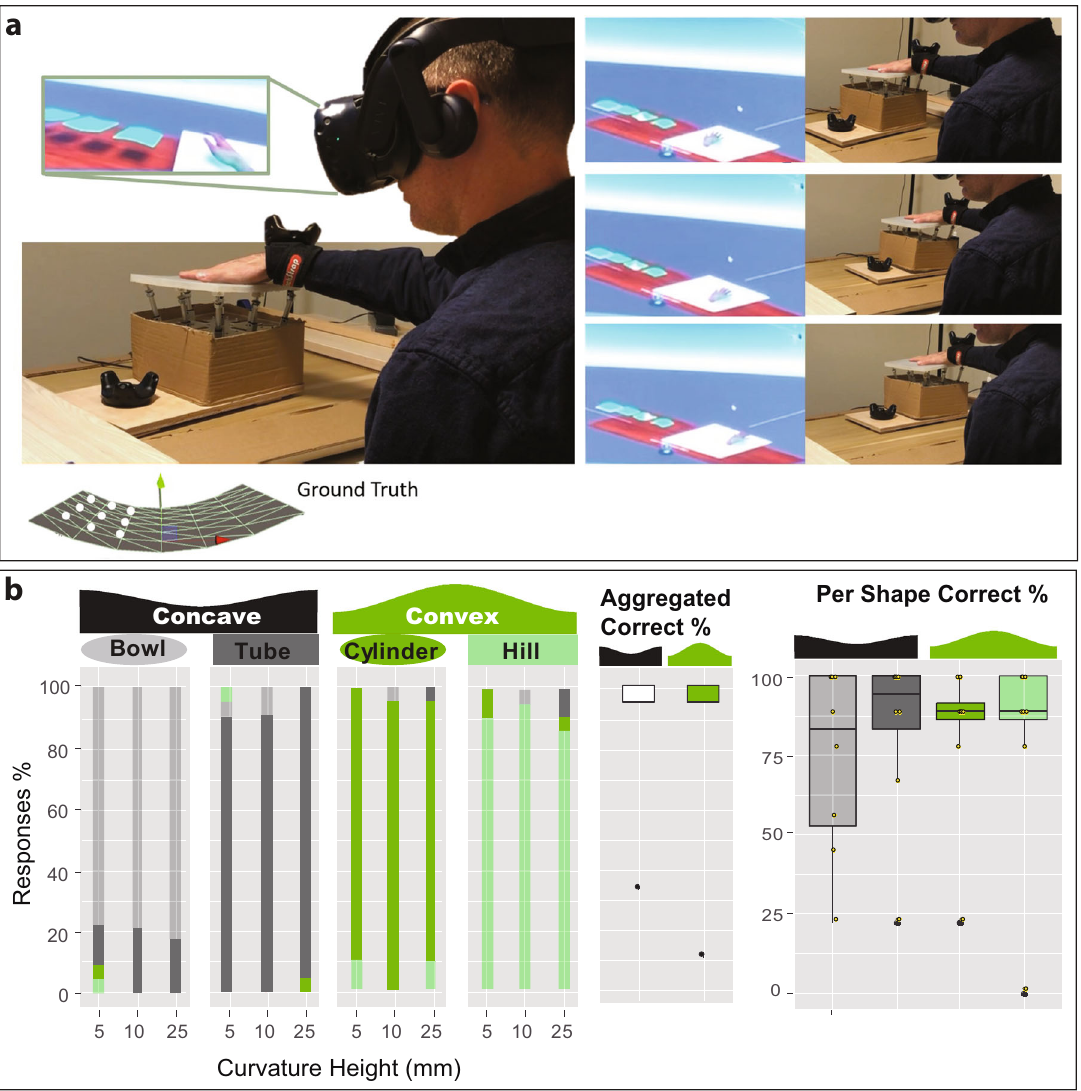
Fig. 8 Moving shape in experiment 3. a A participant exploring a large Concave cylinder used their hand to touch the surface and move the shape display around a larger space while in virtual reality. In this image, we can see a sequence of a participant exploring different areas of the large surface. b The results of the experiment ( n = 9). In this graph, we present the histogram of classi fi cation responses of participants when presented with a particular shape in different curvatures. The boxplot shows the overall ability of the shape display to render concave or convex shapes of different types. For the boxplot: the center line represents the median; box limits represent upper and lower quartiles; whiskers the 1.5× interquartile range; and individual points are the outliers. Yellow dots represent individual participants. Participants had an overall accuracy of 80% in correct recognition of the shapes. No signi fi cant differences were found when the surface-displayed had different curvatures 25mm, 10mm, 5mm, (paired Friedman analysis χ 2 = 1.6, df = 3, p = 0.63). The recognition of surfaces was also not signi fi cantly different across different shapes (Convex or Concave, Conover test with Bonferroni adjustment p >